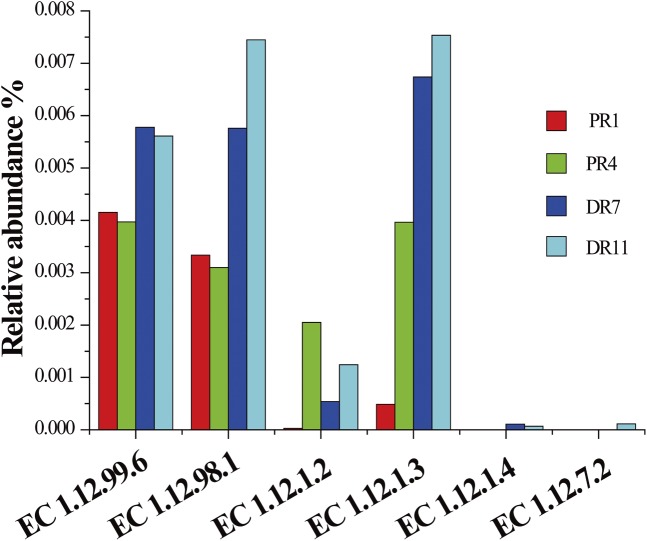
Relative abundances of hydrogenase genes in the four metagenomes.EC 1.12.99.6, hydrogenase or hydrogen:acceptor oxidoreductase; EC 1.12.98.1, F420-reducing hydrogenase; EC 1.12.1.2, NAD+-reducing hydrogenase; EC 1.12.1.3, NADP+-reducing hydrogenase; EC 1.12.1.4, bifurcating hydrogenase; EC 1.12.7.2, ferredoxin hydrogenase.